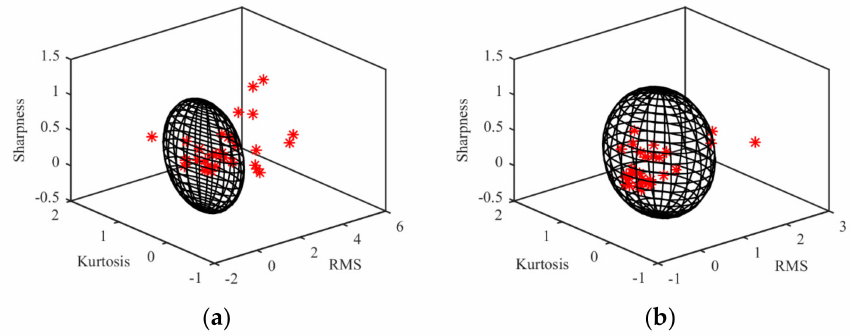
Figure 12. Flywheel #1 test noise sample point and security domain: ( a ) 3000 r / min; ( b ) 4600 r / min.